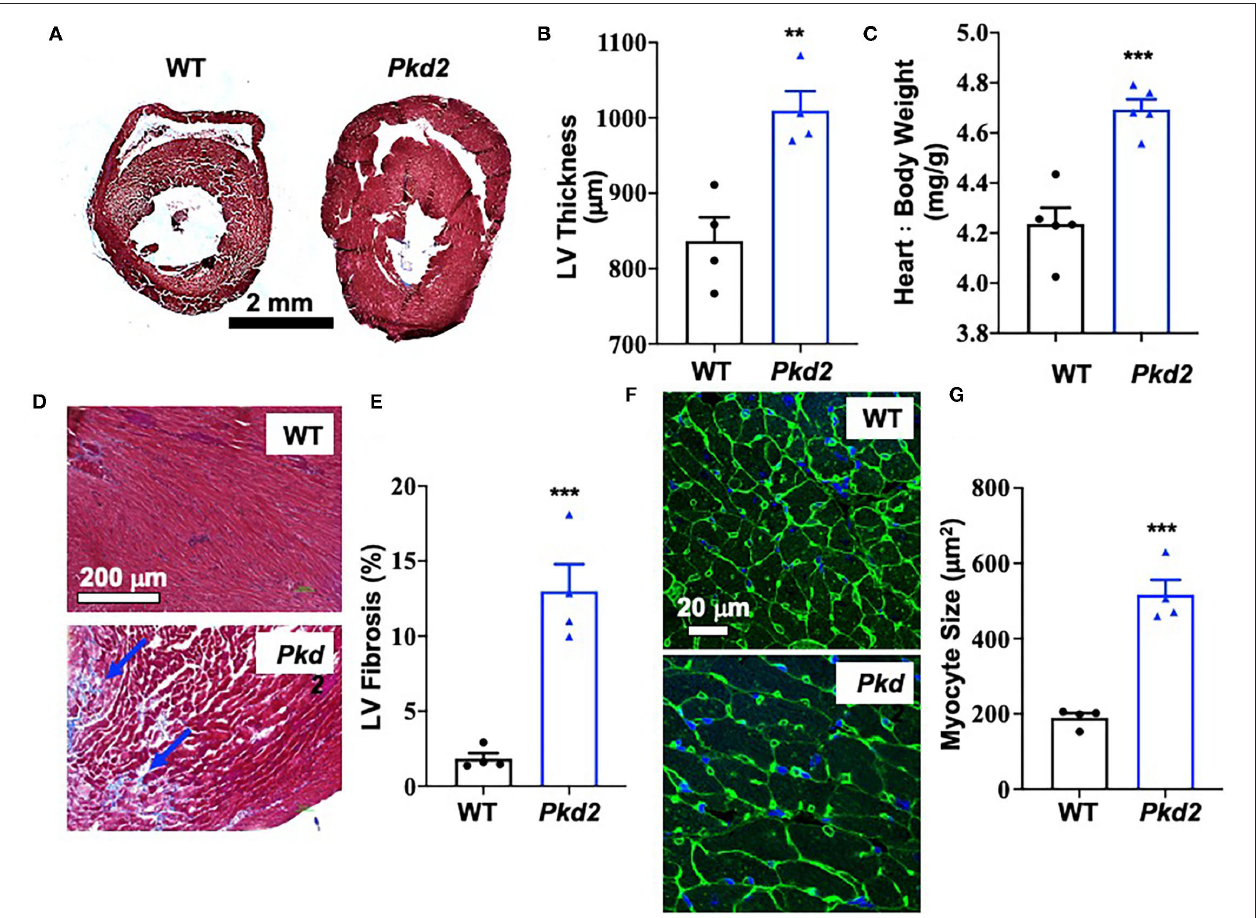
FIGURE 1 | The hearts from Pkd2 -KO mice are characterized with hypertrophy and fibrosis. (A–C) Masson’s trichrome staining was used to analyzed hearts from wild-type (WT) and Pkd2 -KO ( Pkd2 ) mice. Representative of left ventricular thickness (hypertrophy) is shown (A) and quantified (B,C) . (D,E) Left ventricular (LV) fibrosis is analyzed; arrows indicate fibrosis (D) . LV fibrosis was quantified (E) . Data show a significant increase in LV myocardial hypertrophy and fibrosis in Pkd2 -KO compared to WT mice. Fibrosis revealed by trichrome cooperation in the tissue was quantified with binary masking of the blue-color image (D,E) . WGA staining was used for cell surface staining and cell size measurement. Representative of LV cardiomyocyte size (hypertrophy) is shown (F) and quantified (G) . N = 4 mice for each WT and Pkd2 -KO group at age matched of 6 months old. ** p < 0.01; *** p <